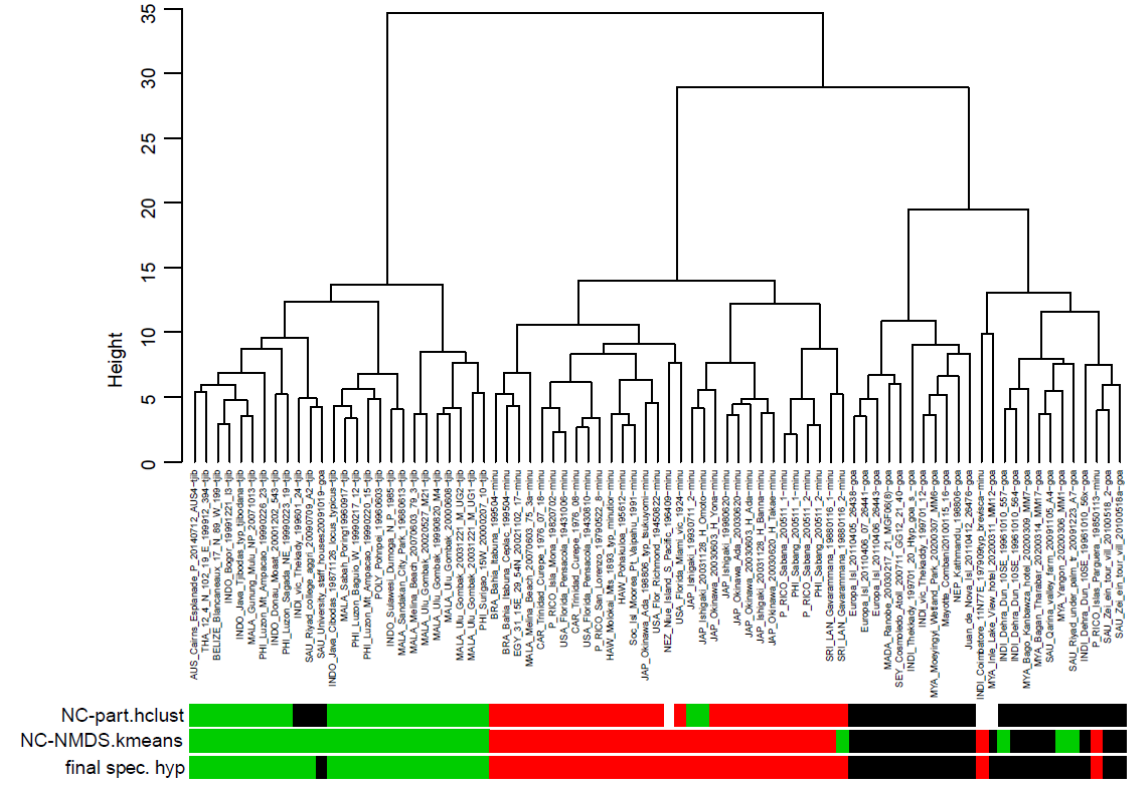
Figure 28. Separation of nest samples of Cardiocondyla tjibodana (green bars), C. minutior (red bars) and C. goa (black bars) by NC-Ward, NC-part.hclust and NC-NMDS.kmeans clustering. White bars indicate outliers in NC-part.hclust. The mean classification error of the three exploratory data analyses relative to the controlling linear discriminant analysis is 5.4%. Fifteen phenotypic characters were considered.